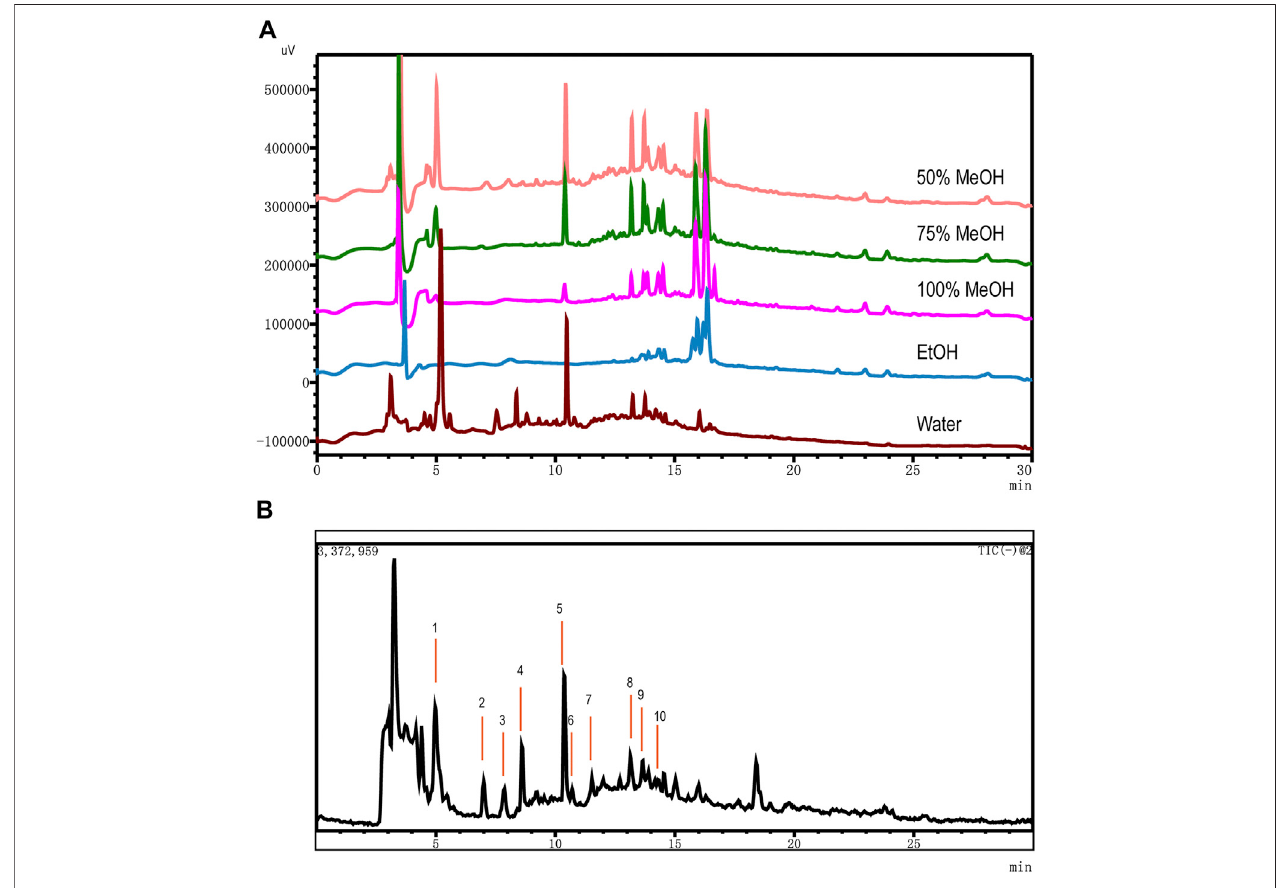
FIGURE 1 | Optimization of extraction solvents and total ion chromatography (TIC) using UHPLC-MS. (A) Comparison of OH dissolved in different solvents: 50% MeOH (pink), 75% MeOH (green), 100% MeOH (fuchsin), EtOH (blue), and Water (brown). (B) TIC in the negative ionization mode of OH dissolved by water.